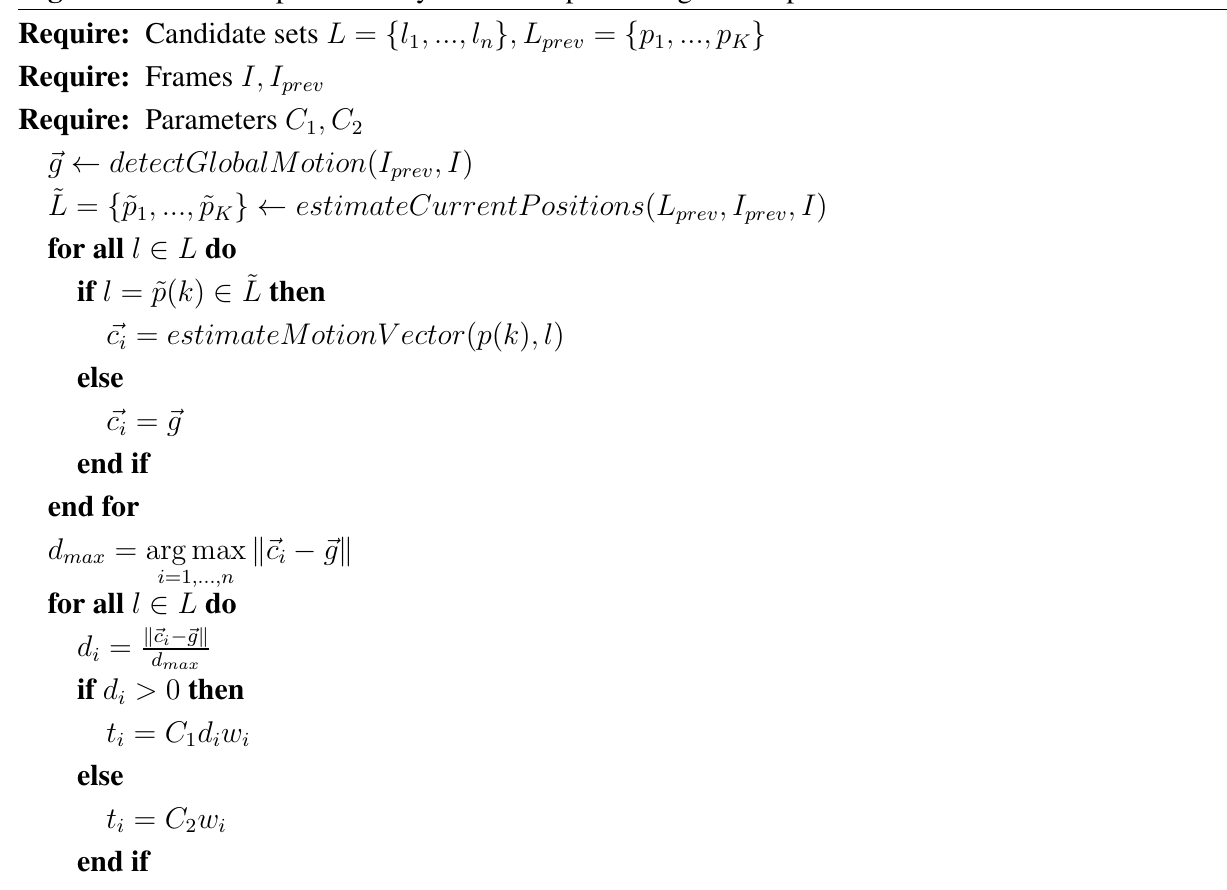
Algorithm 2 Motion pattern analysis and temporal weights